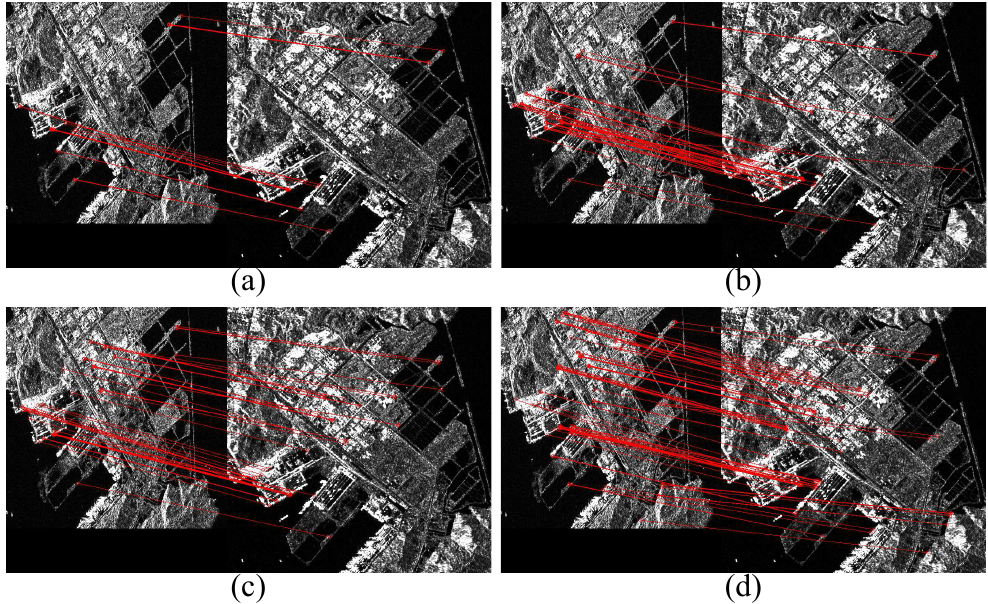
Figure 21. The feature descriptor matching results with different feature descriptor extractors. ( a ) TCPC+SOSNet. ( b ) TCPC+Sim-CSPNet. ( c ) TCPC+CapsNet. ( d ) TCPC+SD-CapsNet.